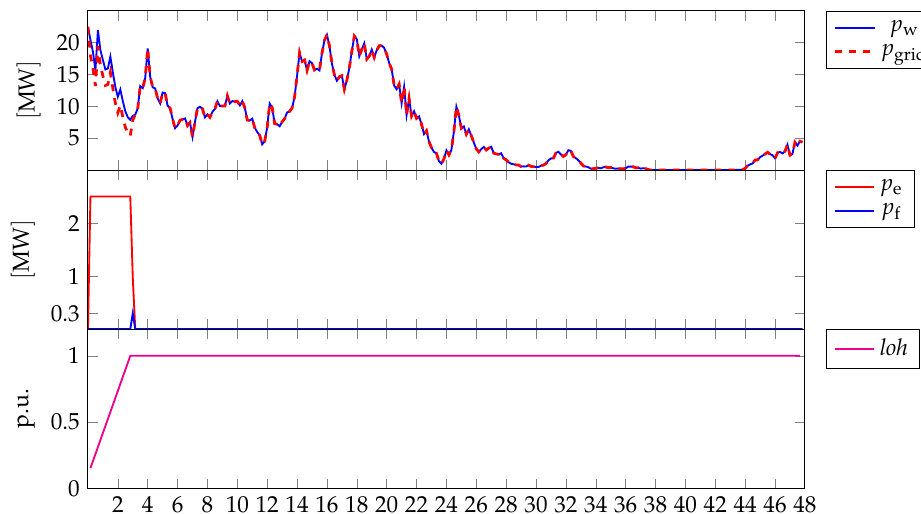
Figure 8. Different profiles related to the reference period from 14:40 of 18 February 2017 to the same hour of 20 February 2017, for highlighting the impact of c loh . First graph: power by wind generation (blue line) and power delivered to the grid (dashed red line); Second graph: power of the electrolyzer (red line) and power of the fuel cell (blue line); Fourth graph: Level of Hydrogen